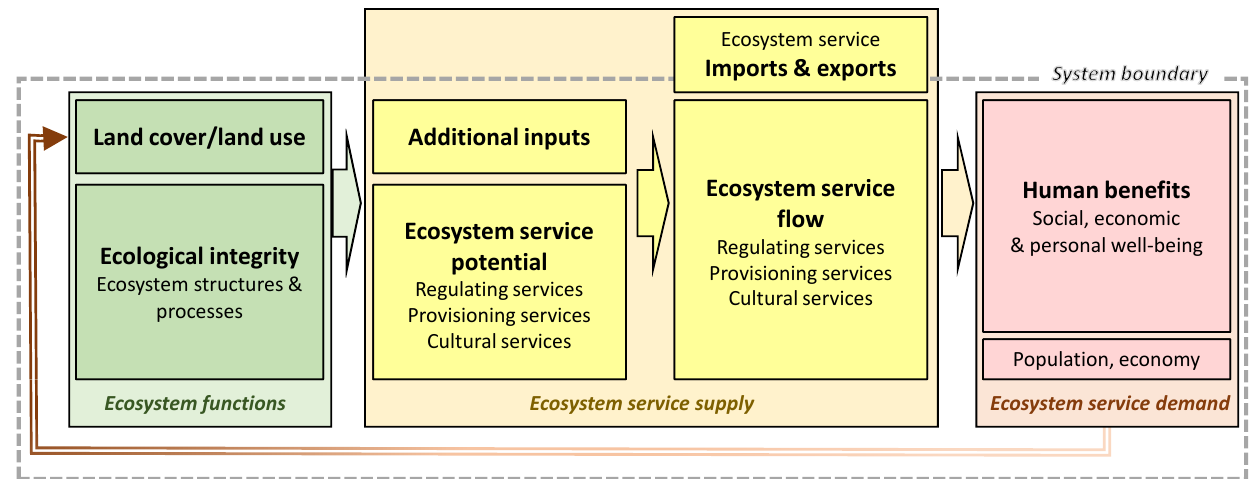
Figure 1: Conceptual model showing relations of ecosystem functions, services and benefits. For definitions, see Box